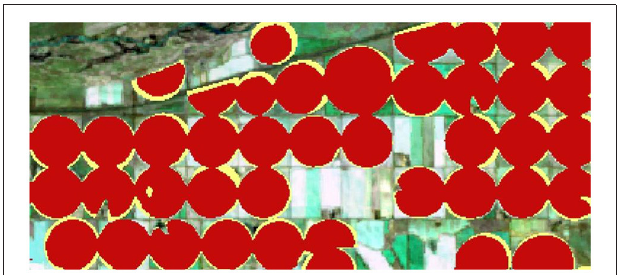
FIGURE 1 | Model output for predicted CPIS from test Image 1. The deep learning model’s output (red) superimposed on the manually identified center pivots (yellow). The model is capable of detecting CPIS of varying sizes and shapes as can be seen near the top of the image. of the difference between the images in performance metrics.